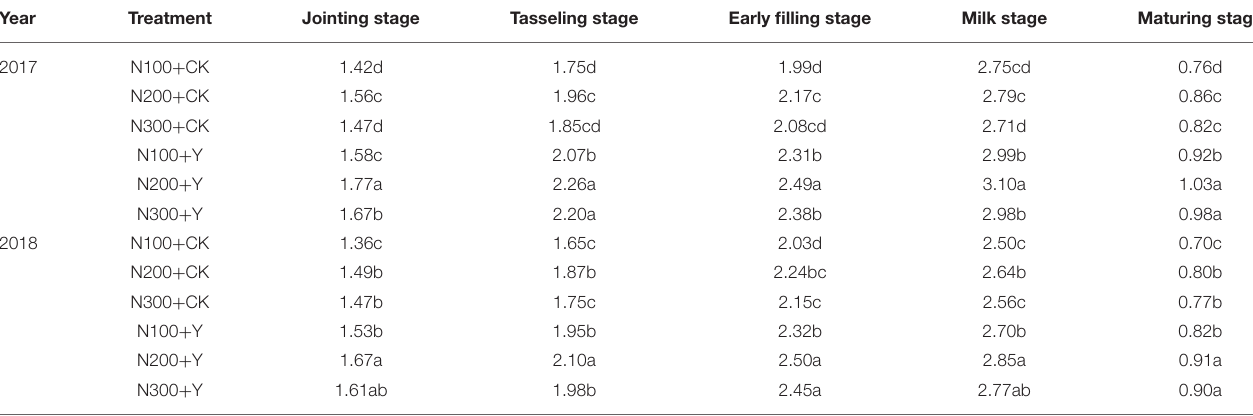
TABLE 1 | Effects of chemical control and nitrogen fertilizers on root-bleeding sap rate ( µ g h − 1 plant − 1 ) during the maize growing period in 2017 and 2018.